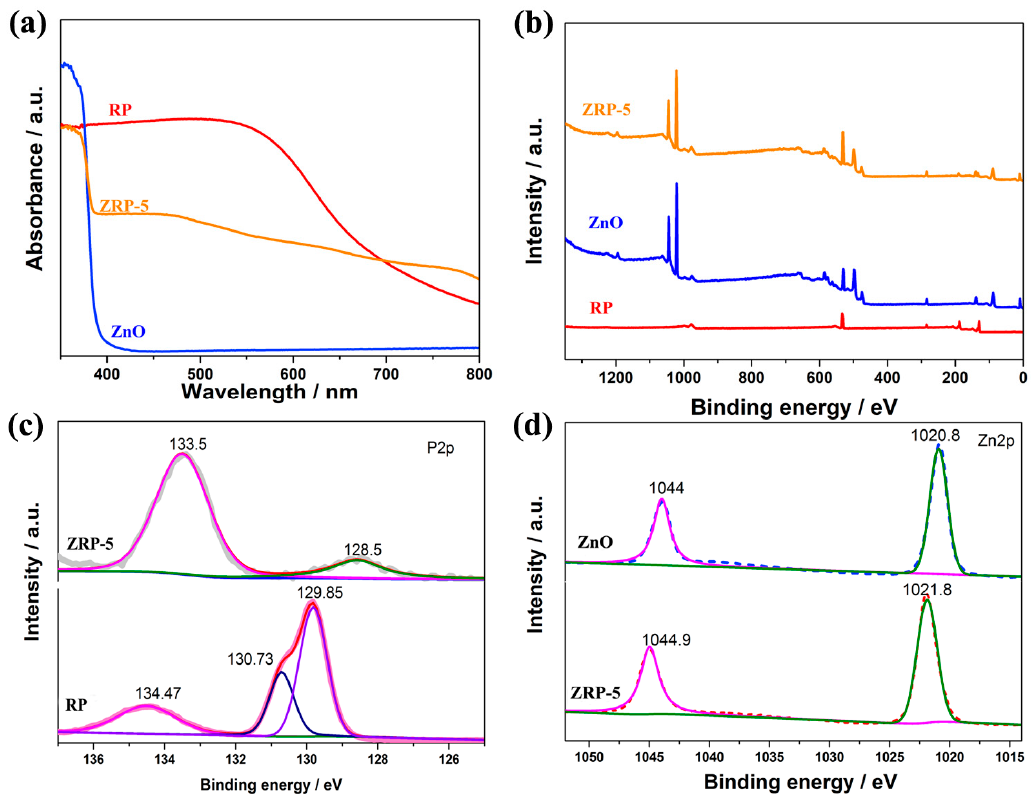
Figure 6. ( a ) UV-vis diffuse reflectance spectra of ZnO, red P and ZRP-5; ( b ) The XPS survey spectra of ZnO, red P and ZRP-5; ( c ) The XPS spectra P 2p of ZRP-5 and red P; ( d ) The XPS Zn 2p spectra of ZnO and ZRP-5.